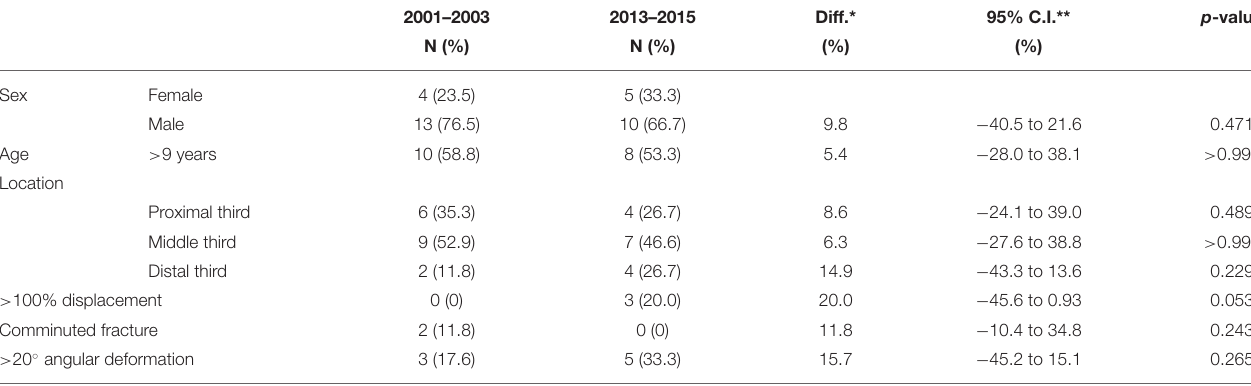
TABLE 2 | The background characteristics of the cases with humeral shaft fractures, by comparing the beginning of the study period to the end of the